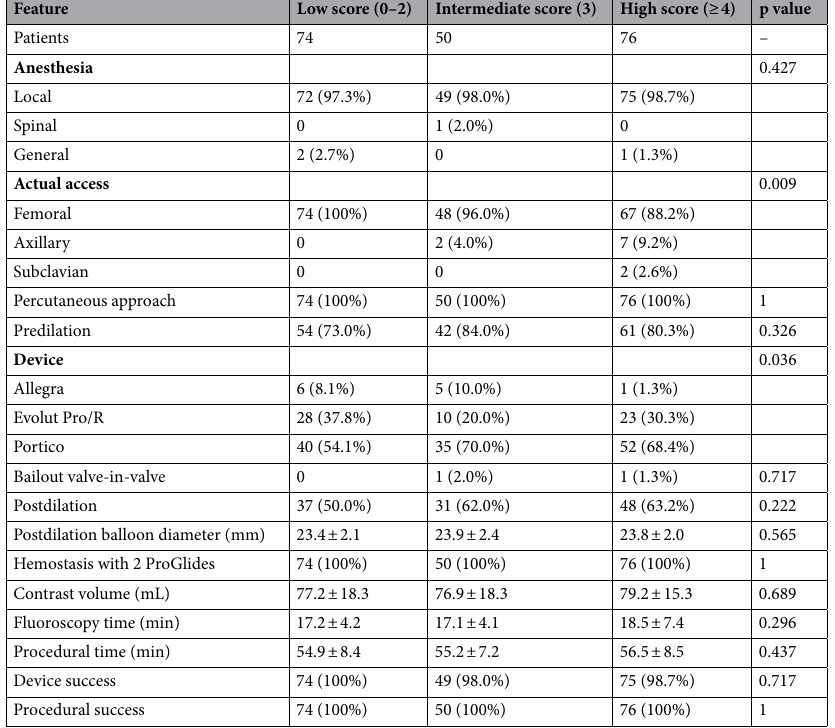
Table 3. Procedural features according to TAVI-CT (transcatheter aortic valve implantation-computed tomography)